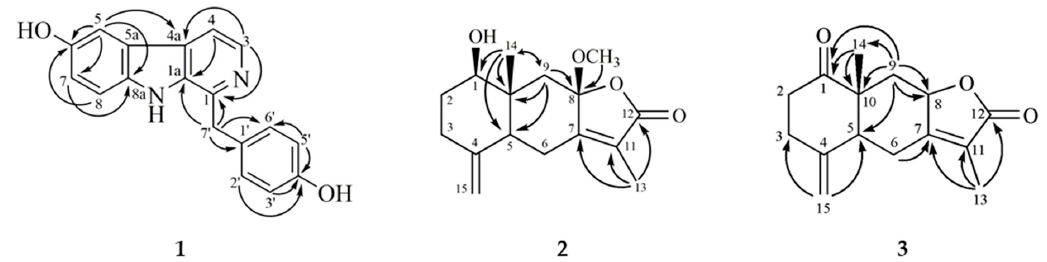
Figure 2. Key HMBC (H → C) correlations of 1 – 3 .